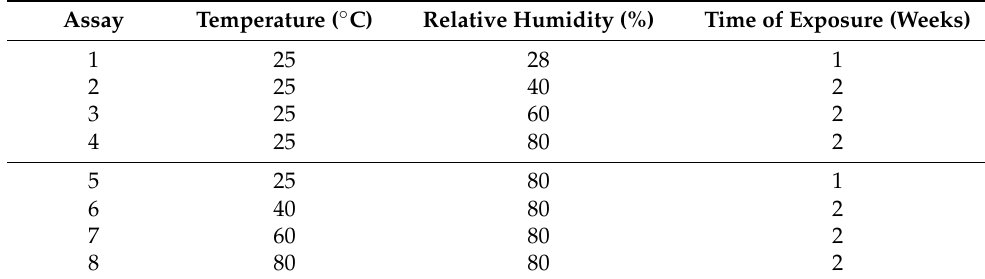
Table 3. Processing parameters in the stability chamber. Assay Temperature ( ◦ C) Relative Humidity (%) Time of Exposure